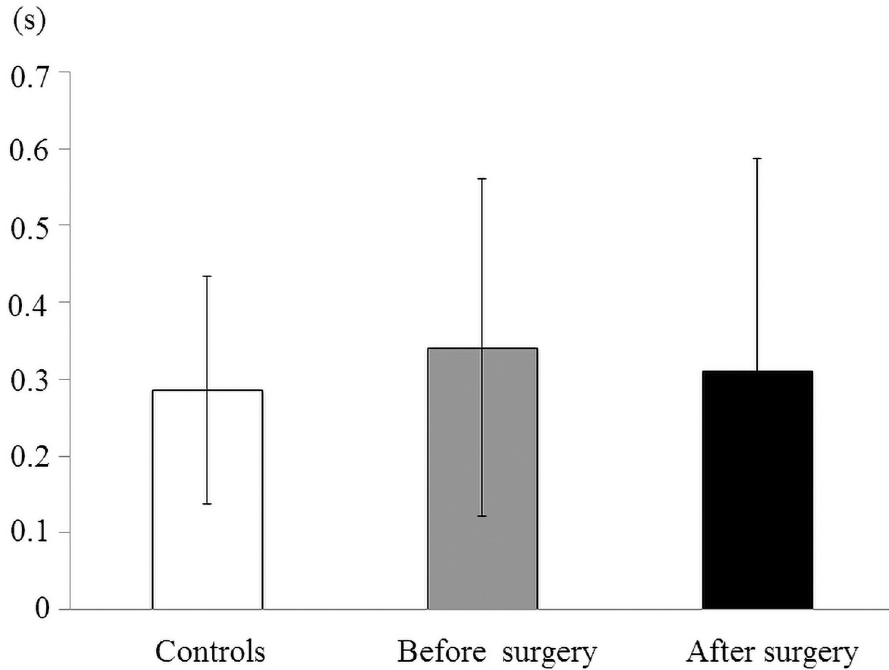
Fig 8. Mean and standard deviation in the duration of swallowing phase in the controls and patients with mandibular prognathism before and after surgery. The duration of the esophageal phase.